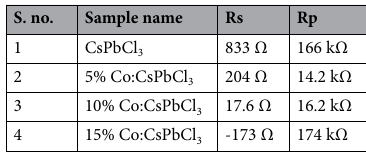
Table 3. Represent Rs and Rp of CsPbCl 3 and Co:CsPbCl 3 .